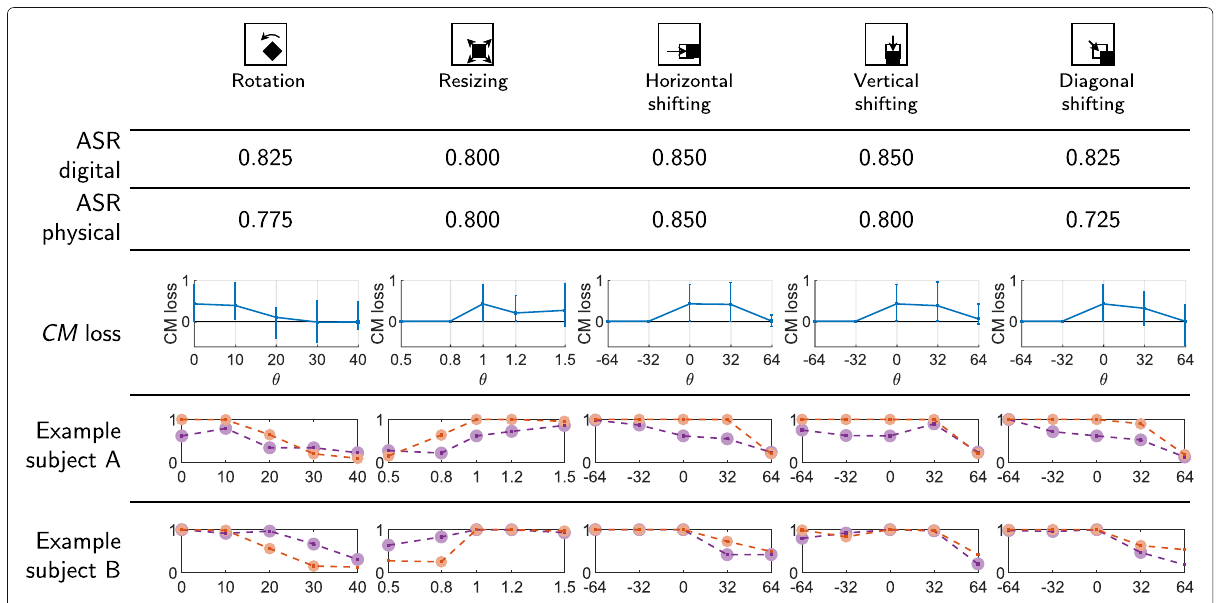
Fig. 9 Results for pairs of digital and physical triggers (transformations in columns; outcomes in rows). The first two rows report the average ASR over all 8 subjects and tested transformation strengths. The third row reports the average loss in classification confidence CM when comparing digital and physical triggers for the same transformation (i.e., a positive loss means decreasing confidence in the physical domain), plotted as a function of the strength parameter (horizontal axis). Vertical bars indicate minimum and maximum loss at each horizontal support point. The last two rows report results for two sample subjects (red for digital, purple for physical trigger). The vertical position indicates CM and bubbles indicate successful attacks (i.e., assignment of the target class)